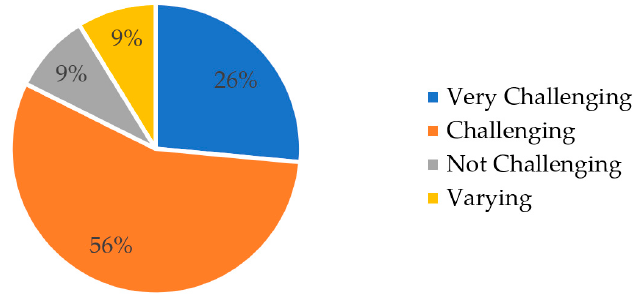
Figure 4. Geological conditions present at mines represented in the survey.